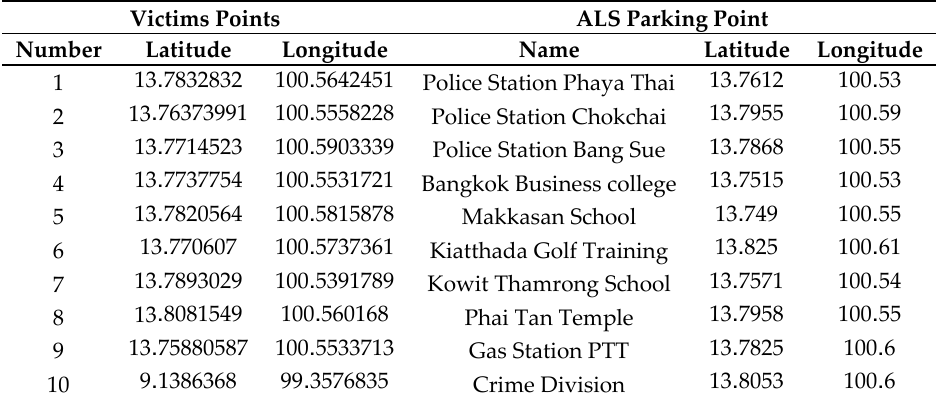
Table 1. Example of rescued locations and ALS parking locations by geographic